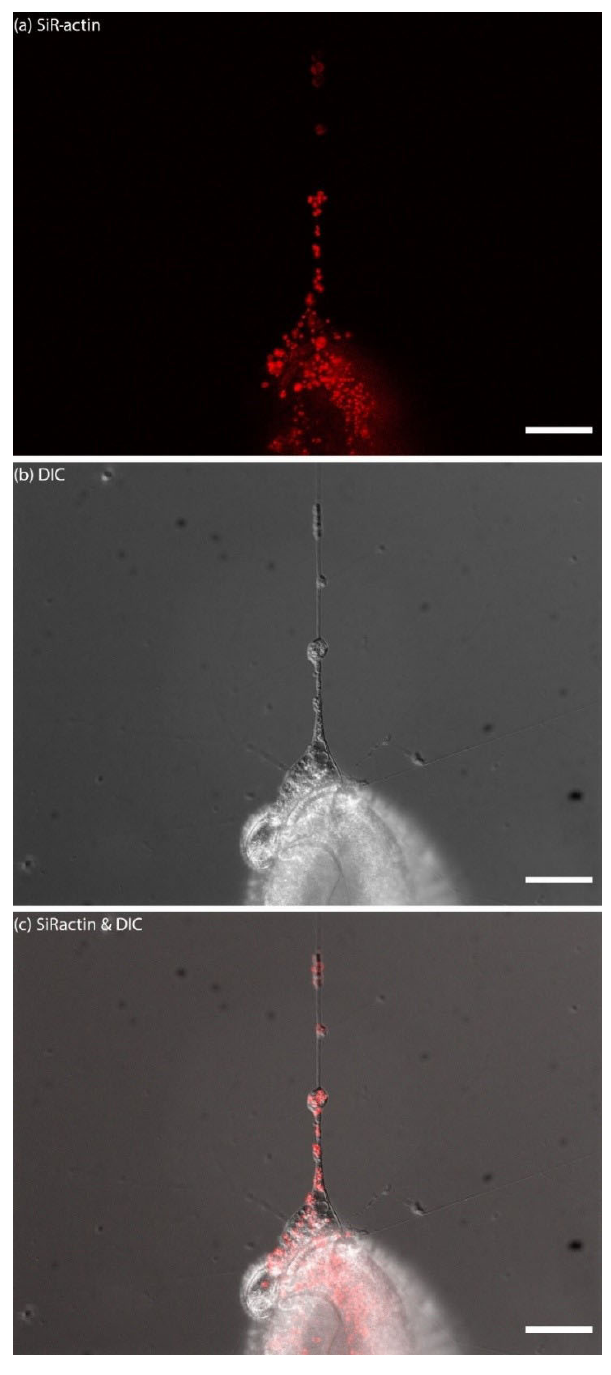
Figure 5. SiR-actin-labelled granules (ALGs) in pseudopodia and endoplasm of Quinqueloculina sp. Panel (a) presents actin stained with SiR-actin, panel (b) presents images obtained with DIC optics (inverted LUT), and panel (c) presents merged fluorescent and DIC channels. Conventional fluorescence images were obtained with a Zeiss Axio Observer Z1 (scale bar